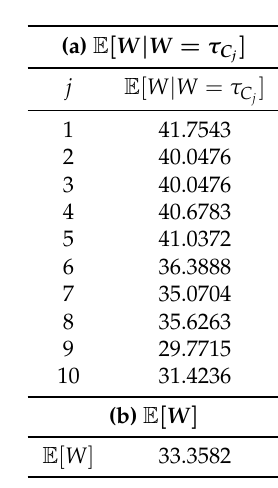
Table 6. The conditional mean E [ W | W = τ C Example